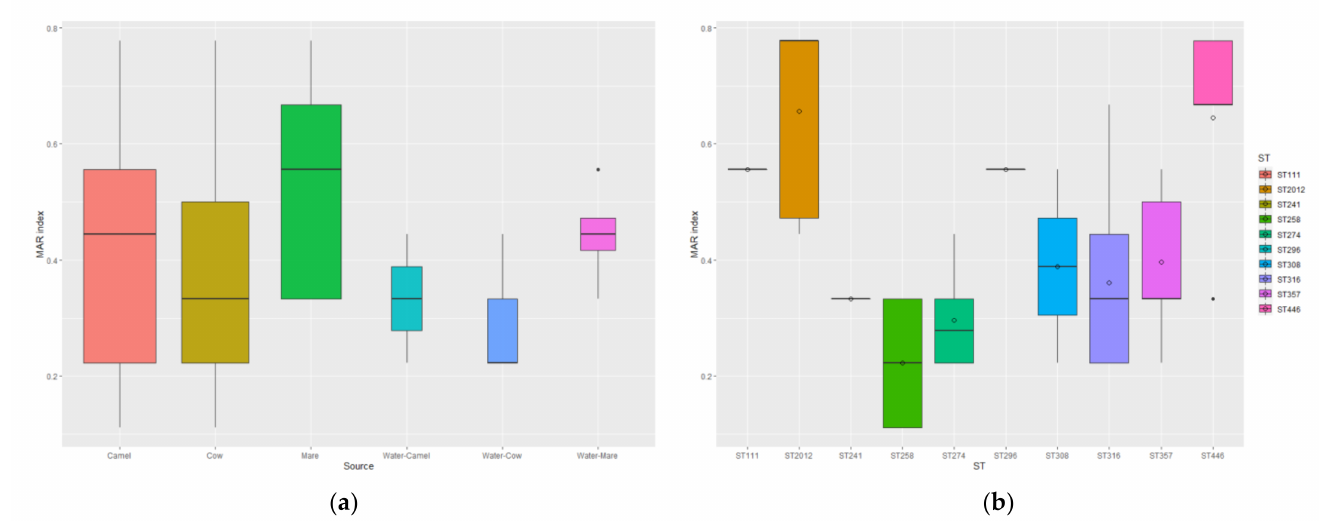
Figure 3. The mean MAR index values for the P. aeruginosa isolates ( n = 54) regarding the source of isolation ( a ) and sequence types ( b ).